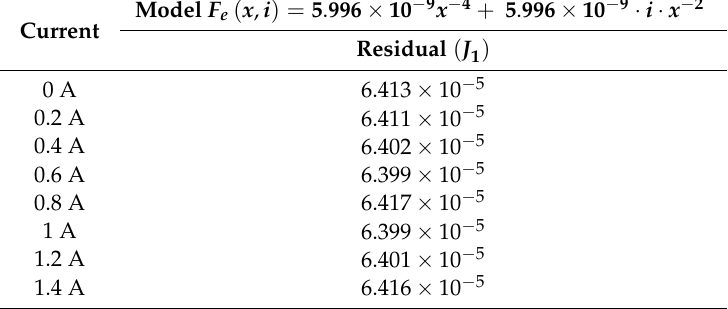
Table 5. Residual value of objective function J 1 with final model F e and FEMM